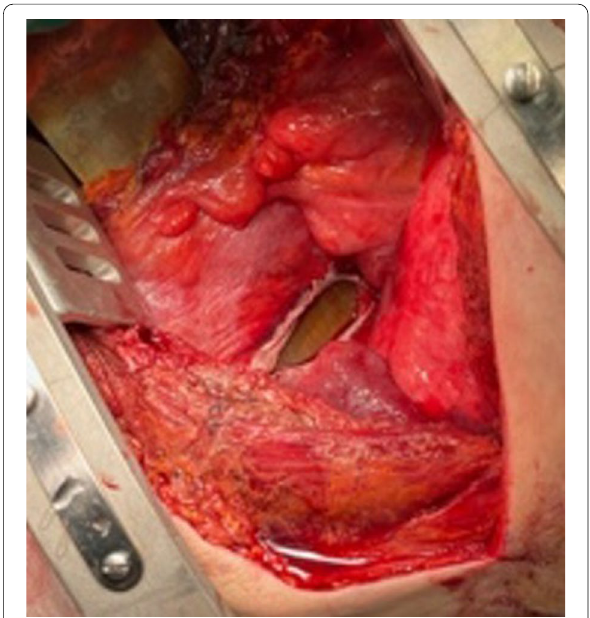
Fig. 3 Rupture of diaphragm. A 5 cm laceration was found in the middle of the diaphragm